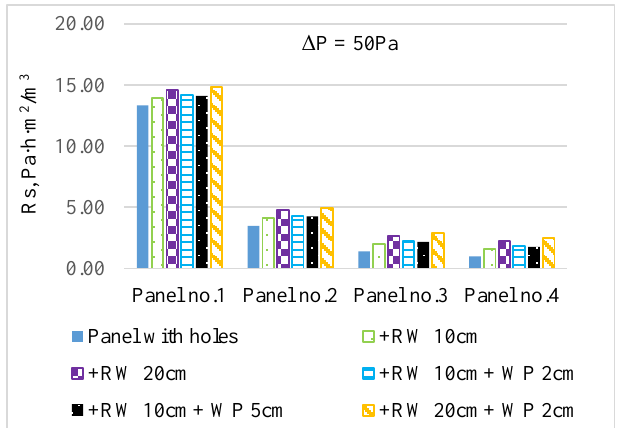
Figure 5. Air flow resistances of four different panels with added thermal insulation and wind protection boards. RW = rock wool thermal insulation, WP = wind protection.